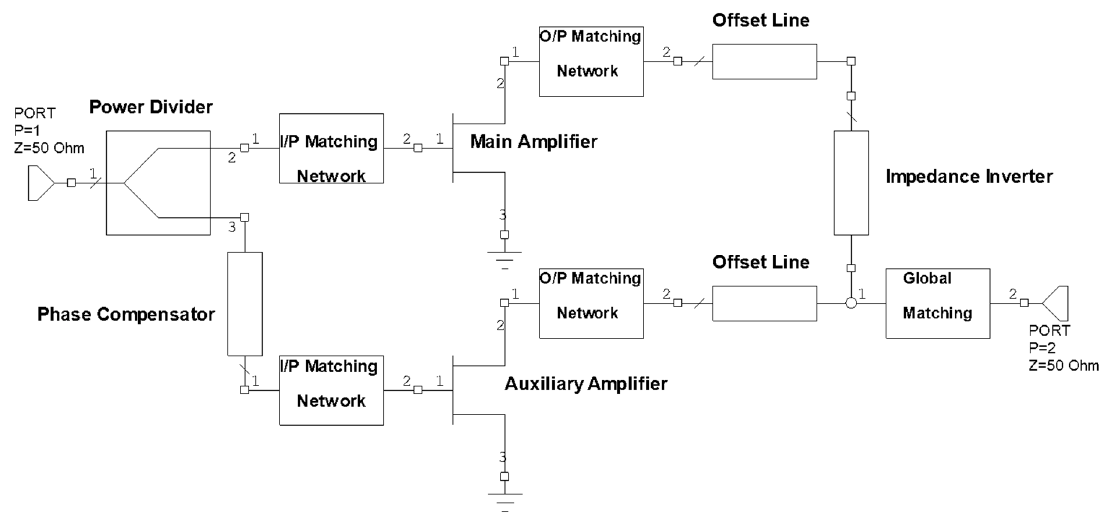
Figure 1. Doherty power amplifier structure [9].